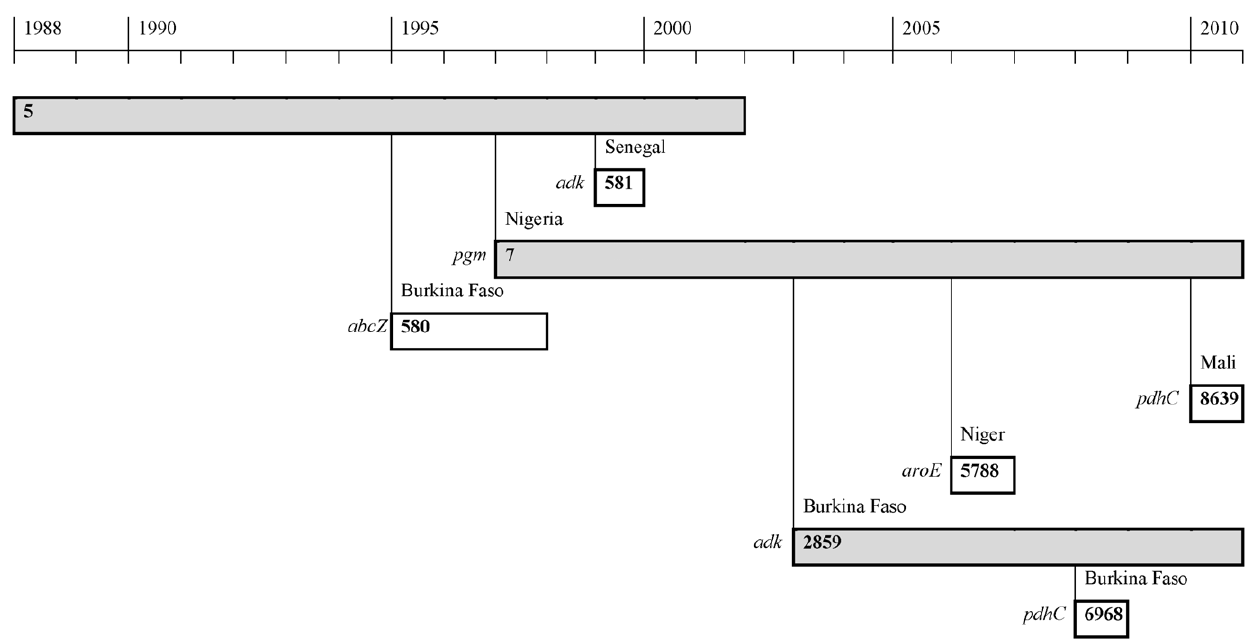
Figure 2. Evolution of the ST-5 complex in the meningitis belt in the period 1988–2010. The ST is shown within the bar, the country where the new ST was first detected is indicated above and the locus changed to the left. The left end of the bar shows when the variant was first detected and the right end shows the last reported isolation. The three dominant STs are marked with grey background.